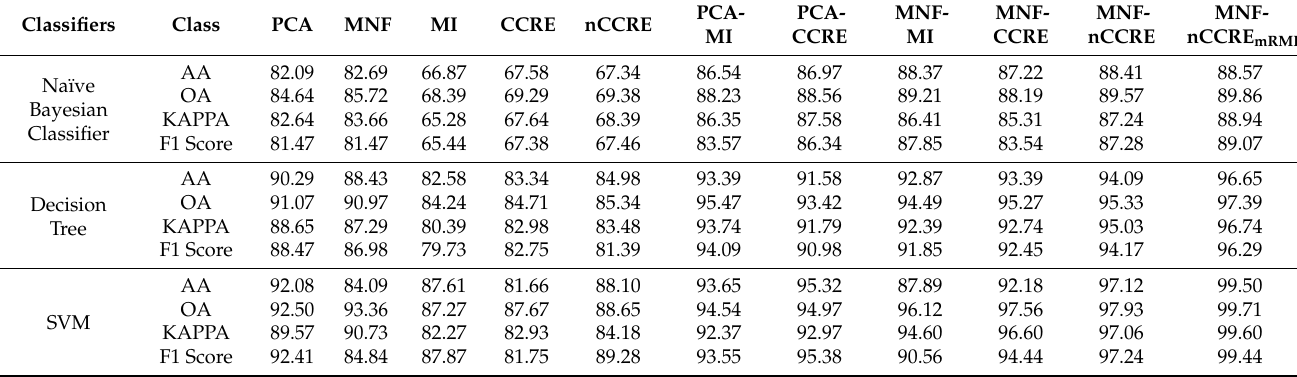
Table 14. Classification performance measure (%) on the HYDICE WDM HSI for different dimension reduction methods and classification